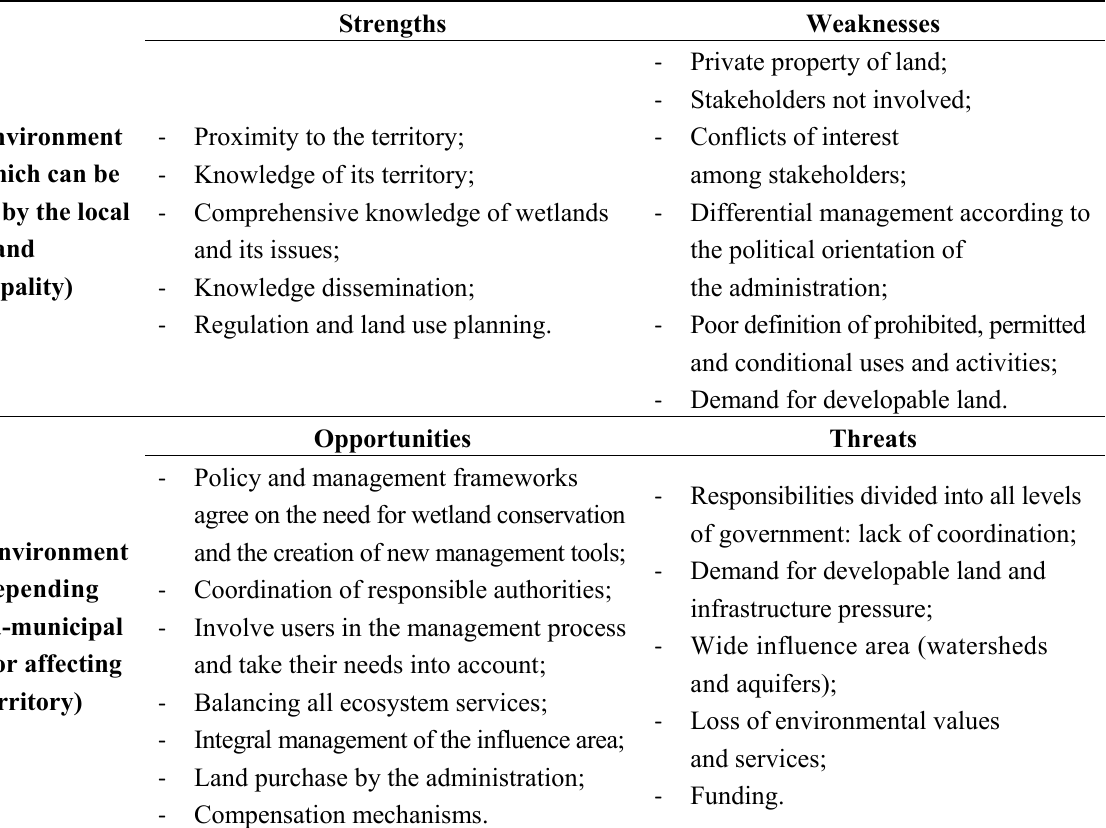
Table 3. Strengths-weaknesses-opportunities-threats (SWOT)